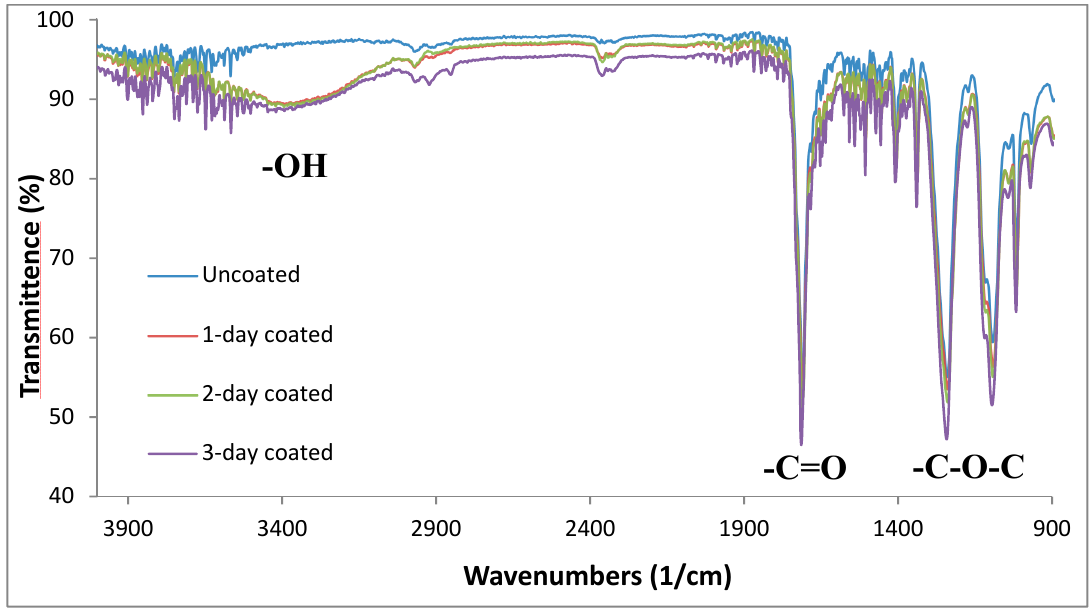
Figure 6. The Attenuated total reflection- Fourier Transform Infrared (ATR-FTIR) spectra of the uncoated and the coated membranes.